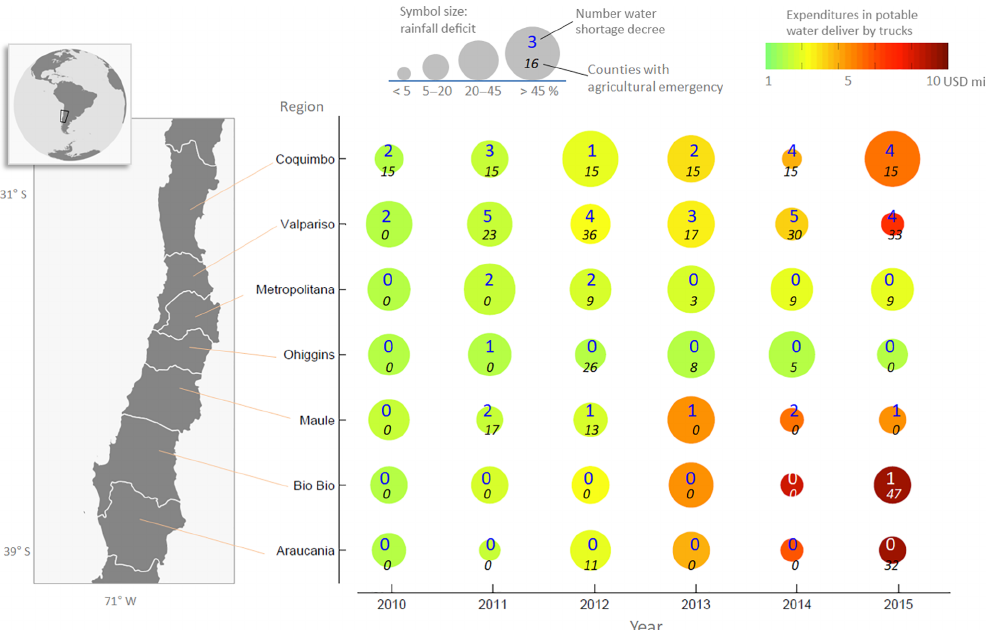
Figure 14. Evolution of the meteorological drought and the state response. The data have been disaggregated by year and administrative region (see map to left). The circle size is proportional to the rainfall deficit, and the circles are colored according to the amount of money spent to deliver potable water by trucks to rural communities, according to the scales on top. The blue, larger numbers indicate the number of water shortages decreed by the Ministry of Public Works (MOP). The smaller numbers in italics indicate the number of counties in agriculture emergency as determined by the Ministry of Agriculture